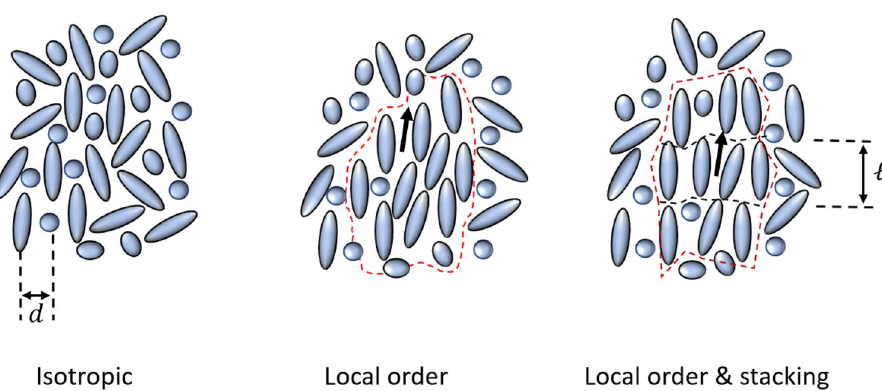
Figure 2. Schematic representations of the short-range local organization of molecules in an isotropic liquid: purely isotropic, clusters with local orientational order but without stacking, and clusters with some degree of stacking. The red dashed line is a guide to an eye and should not be seen as a cluster boundary